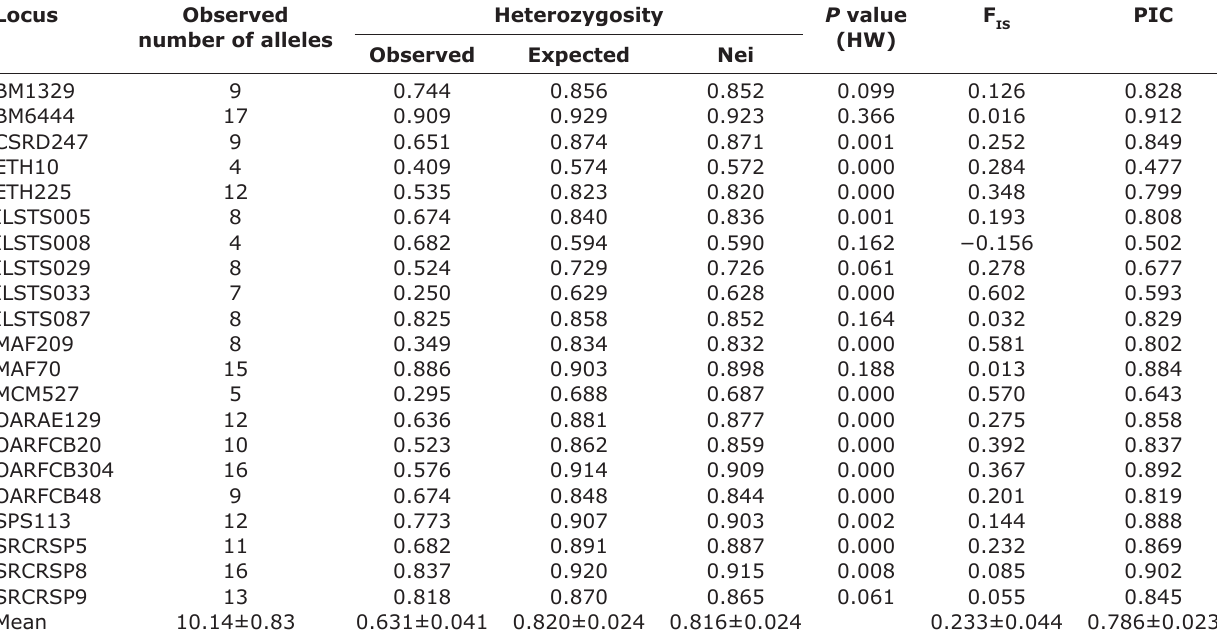
Table-1: Basic diversity indices of Salem Black goats at each microsatellite locu. Locus Observed number of alleles